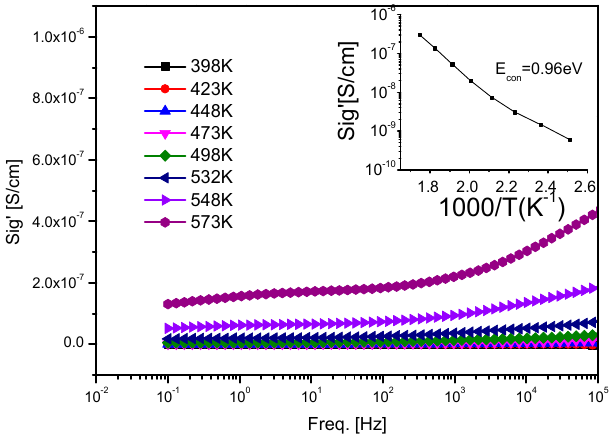
Figure 9. AC conductivity as a function of frequency at selected temperatures for Ta-LTO crystal. The inset shows the date in Arrhenius representation.